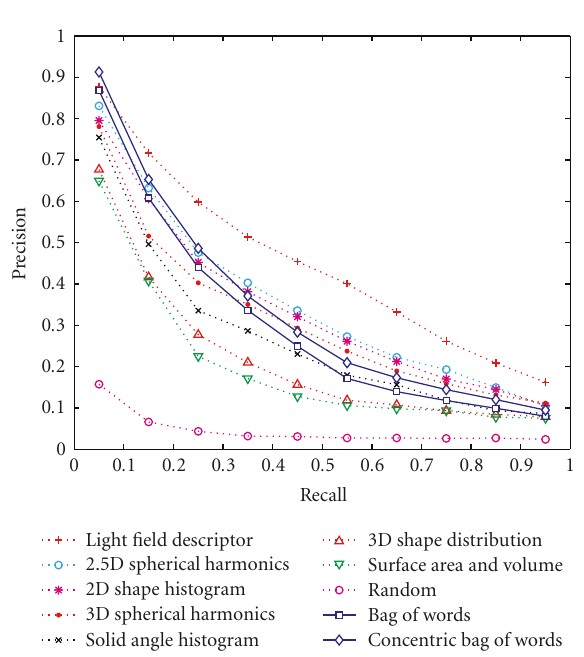
Figure 4: Precision-recall (PR) plots of CBW, BWs, and other methods listed in [12].